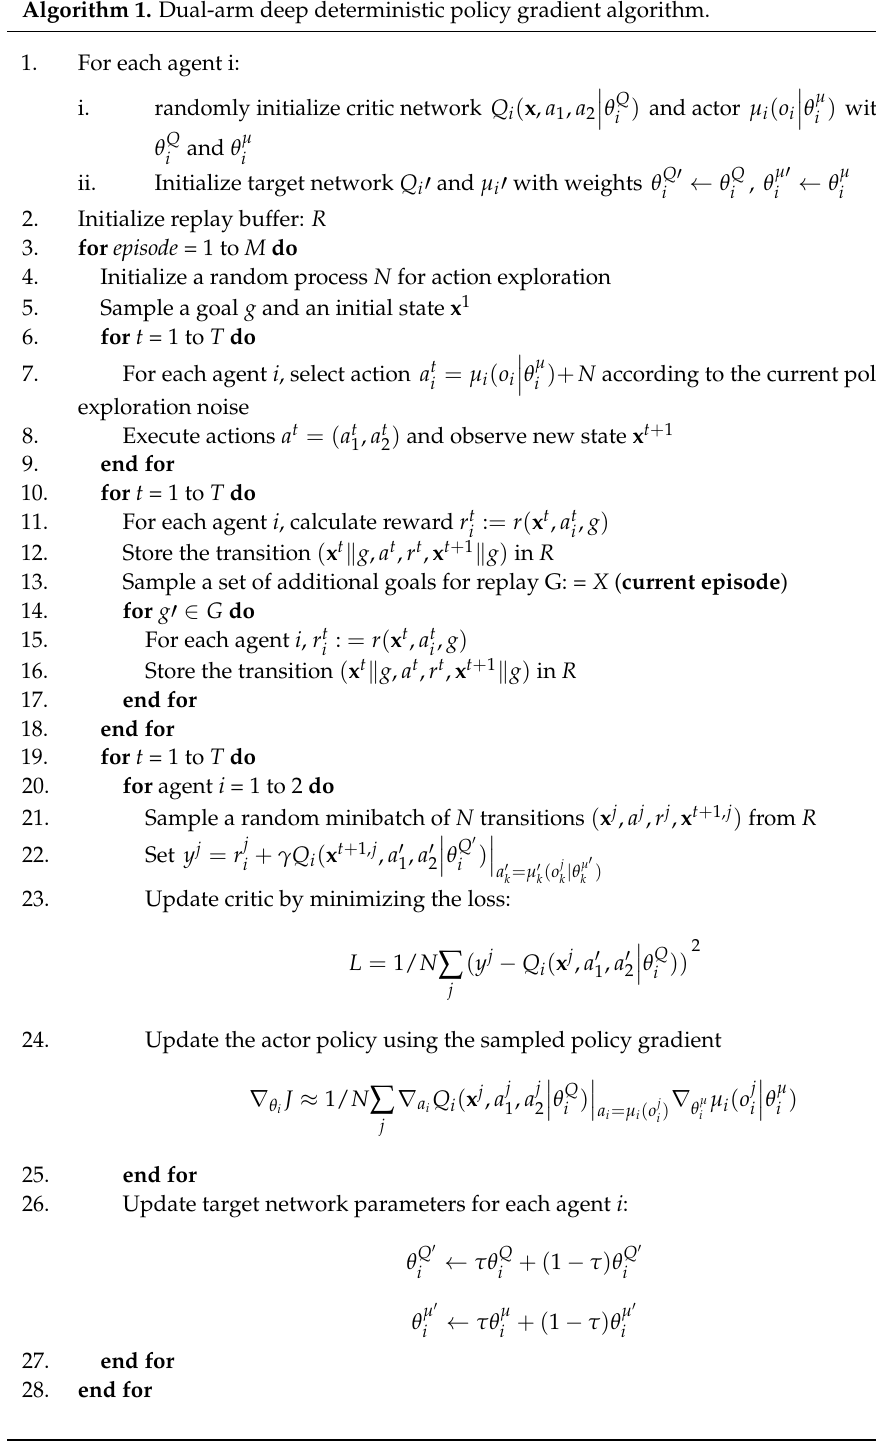
Algorithm 1. Dual-arm deep deterministic policy gradient